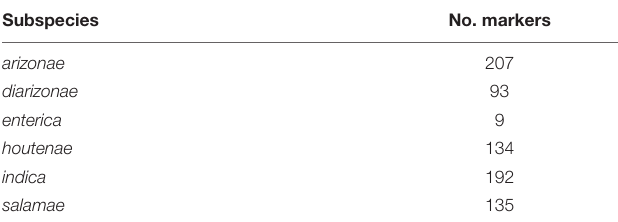
TABLE 5 | The number of subspecies-specific pan-genome markers that were universally present or absent among members of the subspecies, and not absent or present among genomes from any other subspecies.